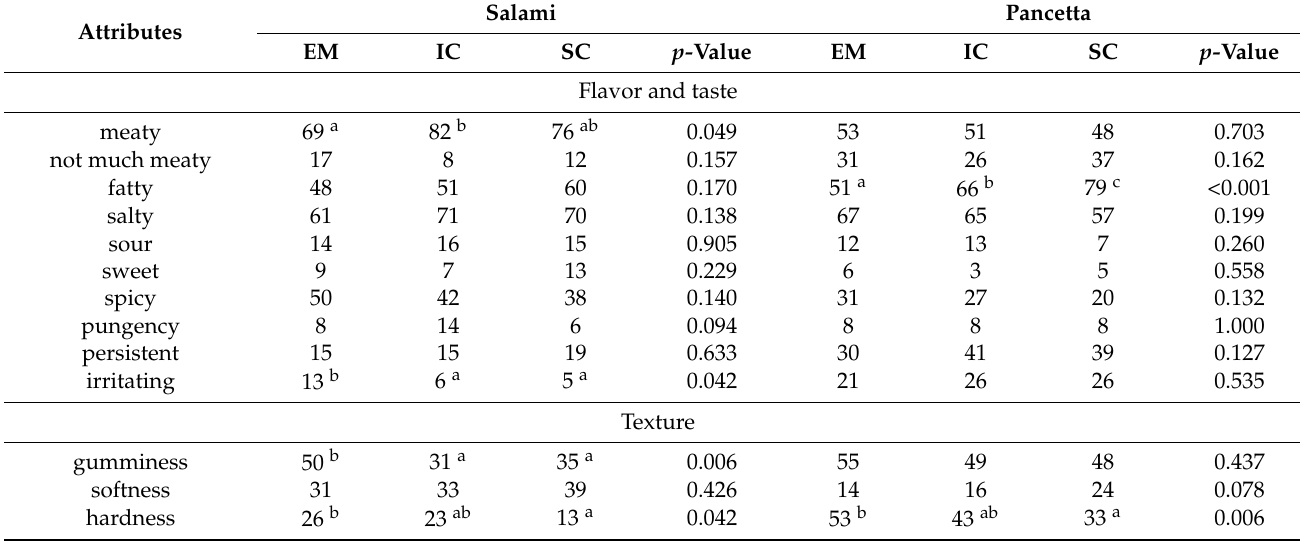
Table 3. Frequency (%) of the use of the sensory terms included in the CATA question for the evaluation of the salami and pancetta products ( n =